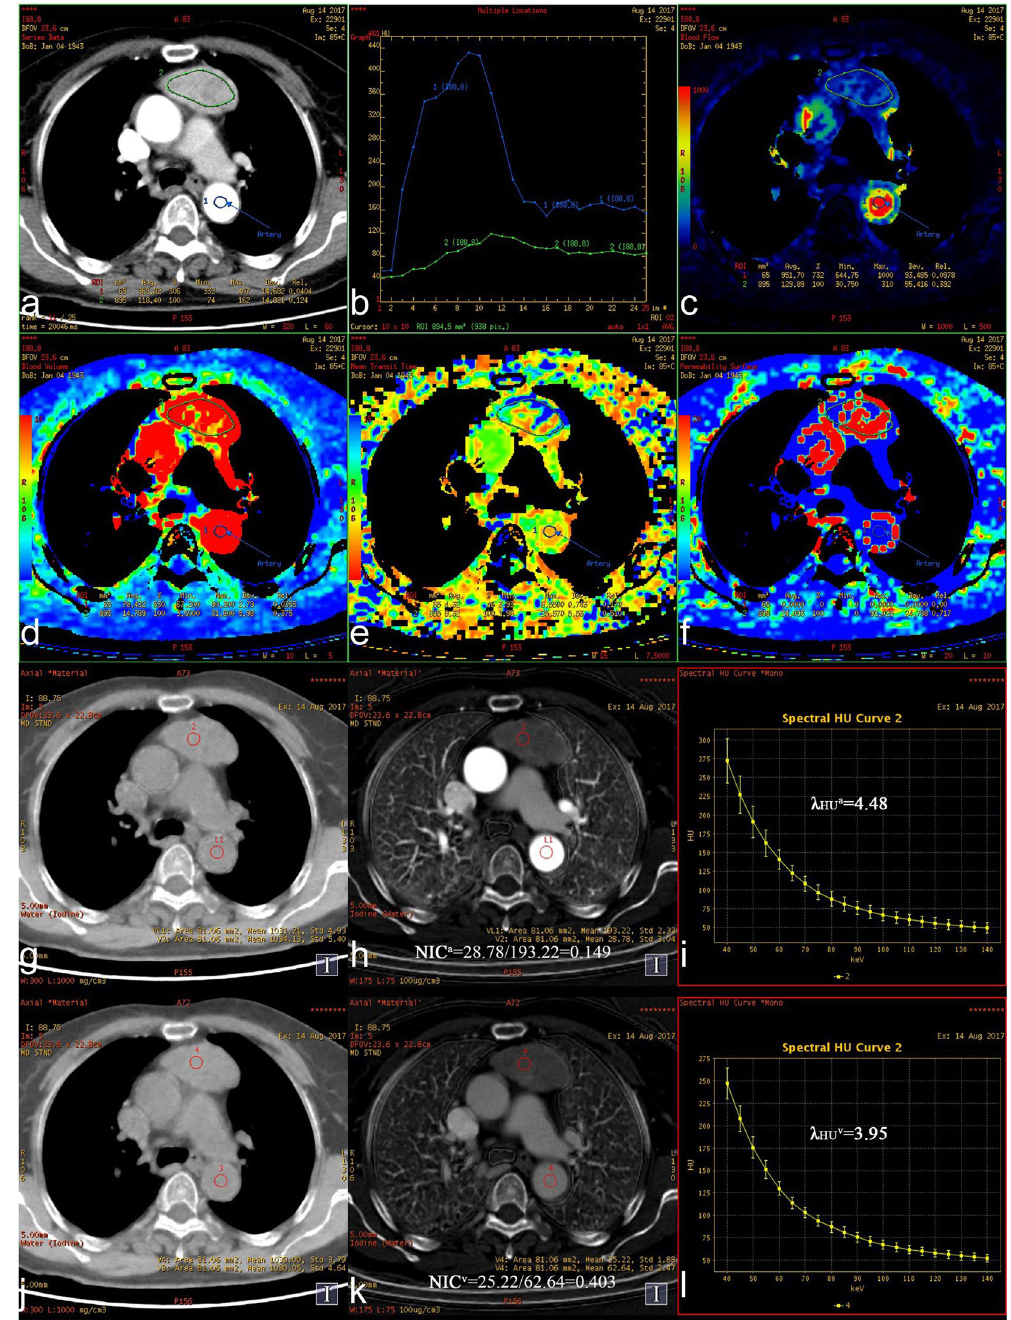
Figure 3. ( a–l ) Axial images showing a thymic carcinoma (75 y, M). (a) Original image (mixed energy) of the chest showing a left anterior mediastinal mass. ROI 1 was selected from the aorta to calculate the TDC curve automatically. ROI 2 was selected from the tumor to calculate perfusion parameters automatically. (b) The optimal arterial phase (tenth) and venous phase (twenty-first) were obtained in the TDC curve. ( c , d , e , f ) BF, BV, MTT, and PS value were 61.71 ml/min/100 g, 7.03 ml/100 g, 9.47 s and 41.33 ml/min/100 g respectively, in pseudo-color maps. ( g , h , i ) WC a , IC a , NIC a and λ HUa values of the tumor were 1038.60 mg/cm 3 , 11.83 × 10 2 μ g/cm 3 , 0.087, and 1.90 in the Water (Iodine), Iodine (Water) and spectral curve maps respectively, in the optimal arterial phase. ( j , k , l ) WC v , IC v , NIC v and λ HUv values of the tumor were 1040.87 mg/cm 3 , 14.18 × 10 2 μ g/cm 3 , 0.357, and 2.28 in the Water (Iodine), Iodine (Water) and spectral curve maps respectively, in the optimal venous